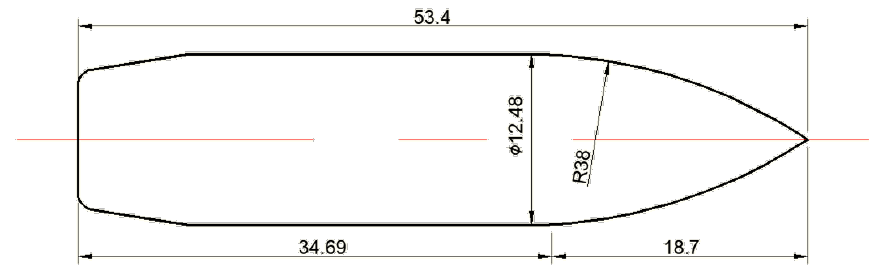
Figure 13. Geometry and dimensions (in mm).